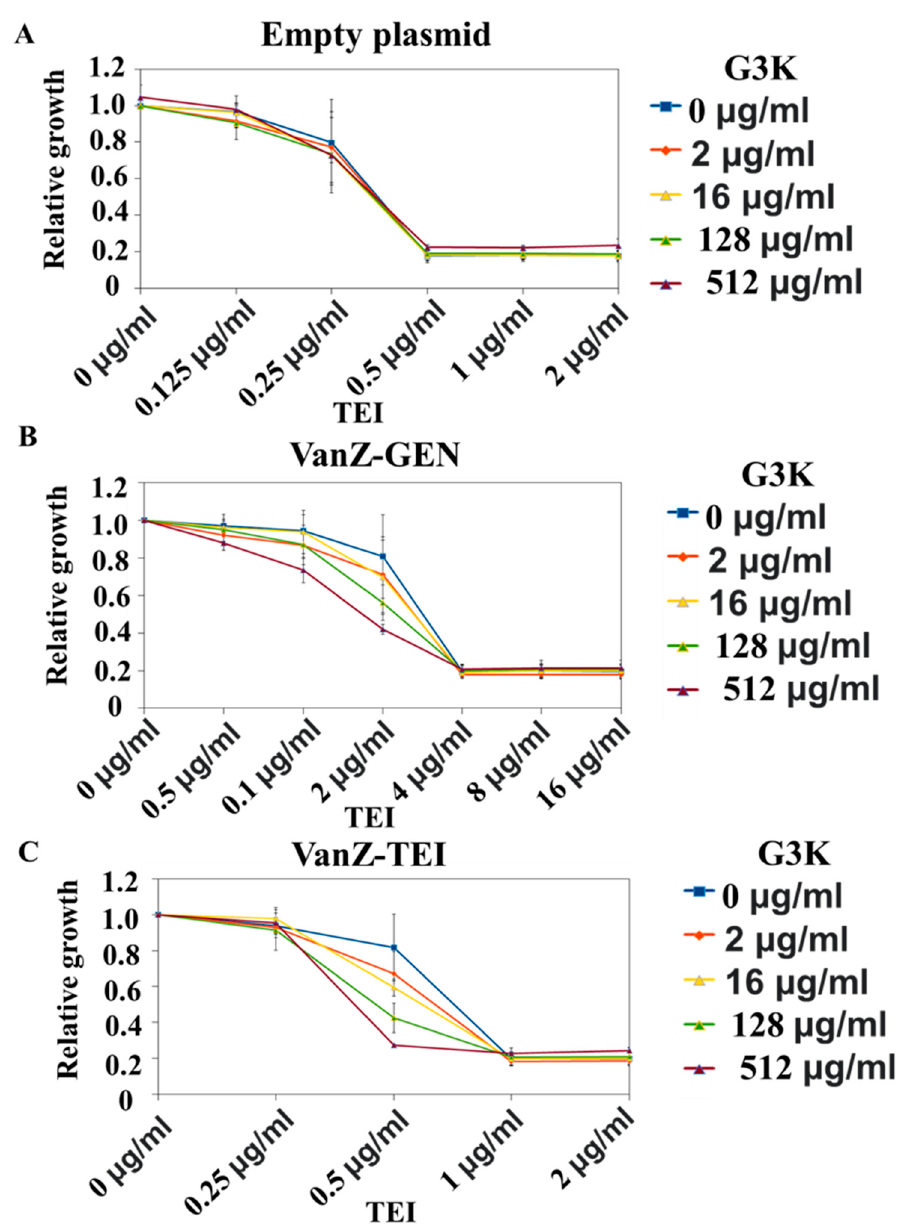
Figure 6. Effect of G3K on VanZ-mediated resistance to teicoplanin (TEI). ( A ): Where S. aureus RN4220 strain with empty plasmid was used. ( B ): Where S. aureus RN4220 strain heterogeneously expressing VanZ-GEN ( vanZ encoded in the E. faecium genome) was used. ( C ): Where S. aureus RN4220 strain heterogeneously expressing VanZ-TEI ( vanZ encoded in the vanA resistance gene cluster) was used. Data represent the mean ± SD, n = 3.